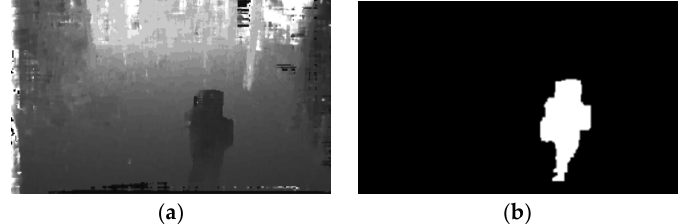
Figure 8. Background subtraction result: ( a ) depth map, and ( b ) background subtraction result.